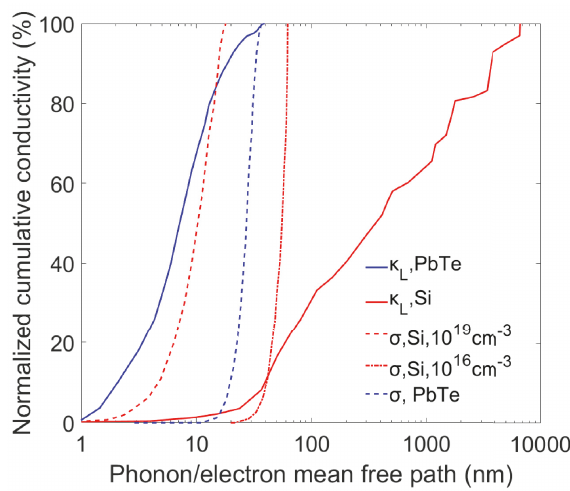
Figure 4: Normalized cumulative conductivity (at 300K), i.e., electrical conductivity 𝜎 and lattice thermal conductivity 𝜅 𝐿 , with respect to the corresponding electron or phonon mean-free-path for Si [58] and PbTe [59]. The normalized cumulative conductivity quantifieshowmaterialsizecanaffecttheconductivityofnanomate- rials, i.e., the percentage of conductivity remaining (vertical axis) for aspecificsize(horizontalaxis)ofnanomaterialduetothetruncation of mean-free-path by materials’